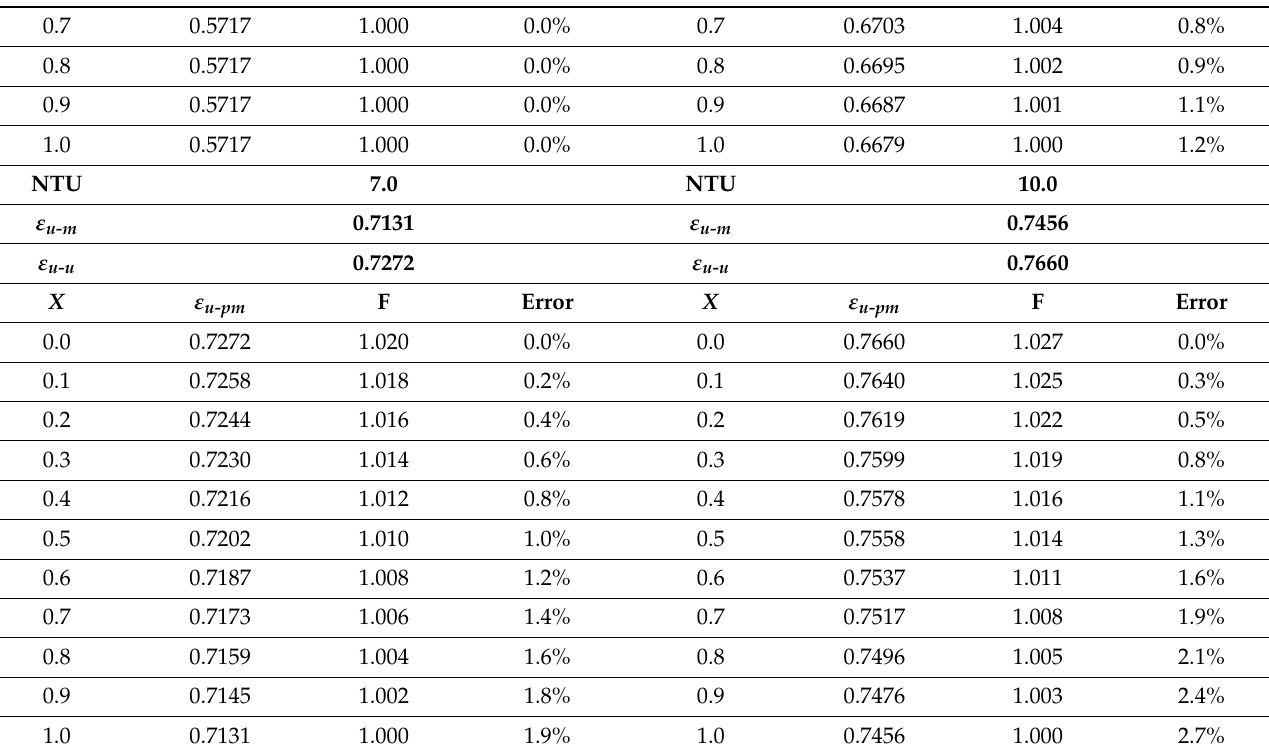
Table A4. Effectiveness correction factor “F” and Error in effectiveness estimation—3-row pure cross flow heat